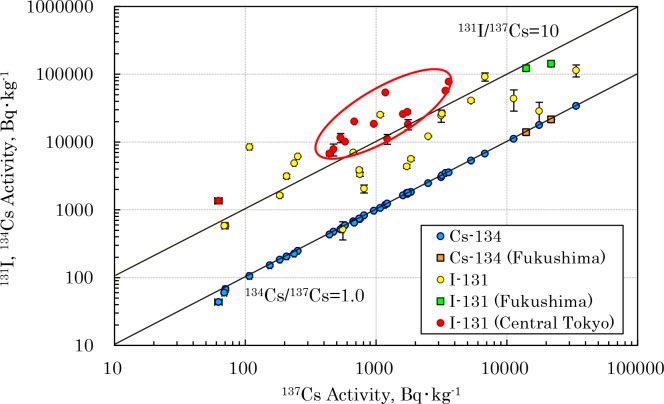
Activity ratios of 131I/137Cs and 134Cs/137Cs in the soil collected from eastern Japan.